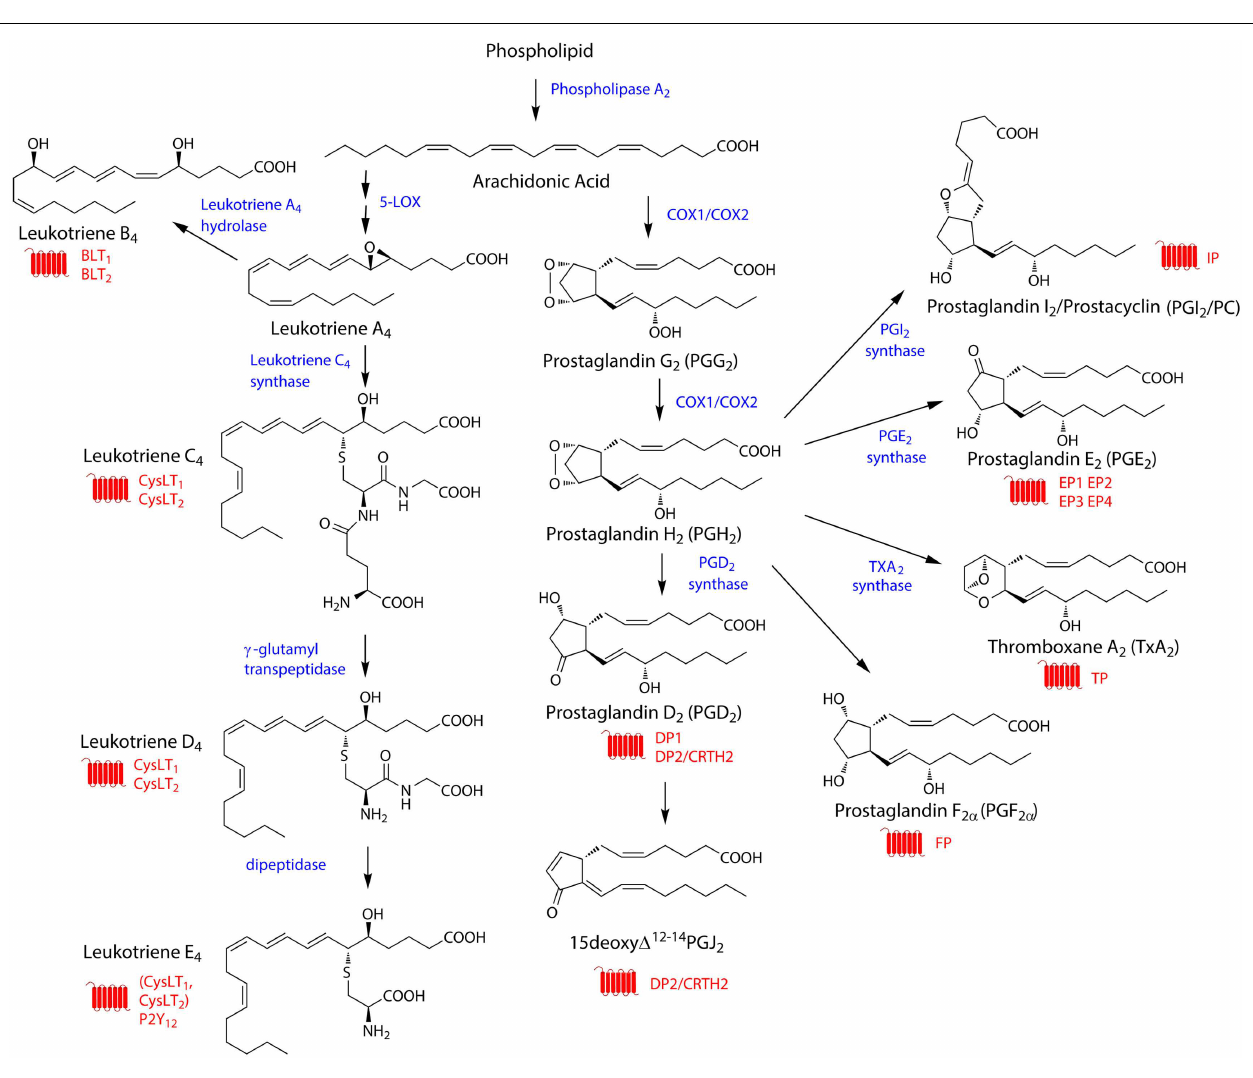
(black), and indicates the enzymes involved in their biosynthesis (blue), as well as the GPCRs through which these eicosanoids signal (red). PGF 2 α can be synthesized through a number of different